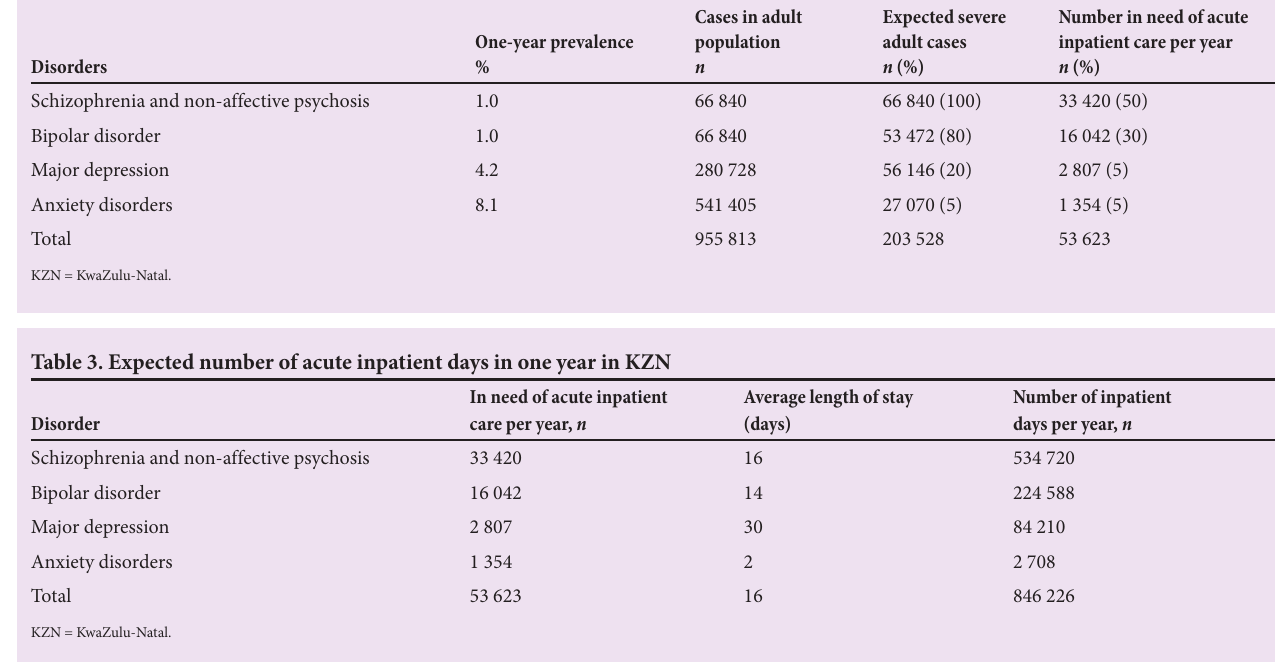
Table 2. Expected number of individuals requiring acute inpatient care in one year in KZN